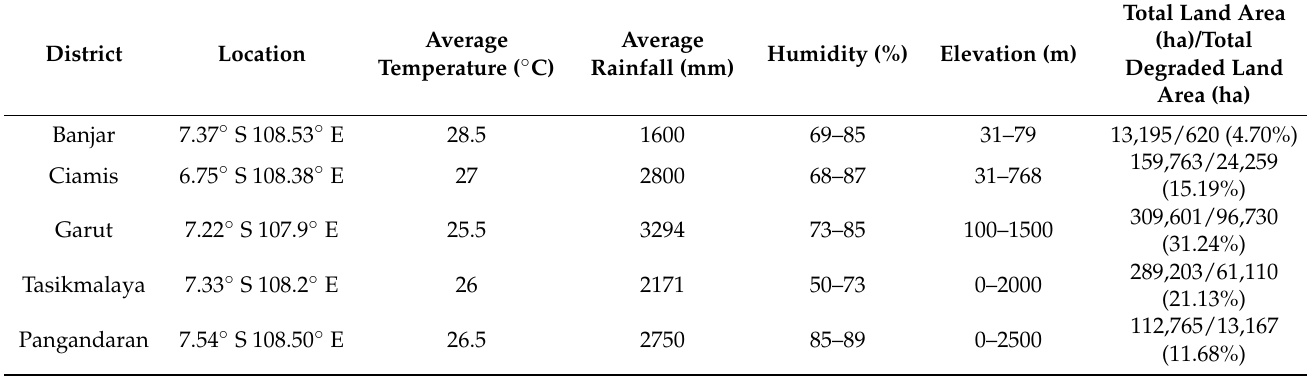
Table 1. Basic characteristics of the research